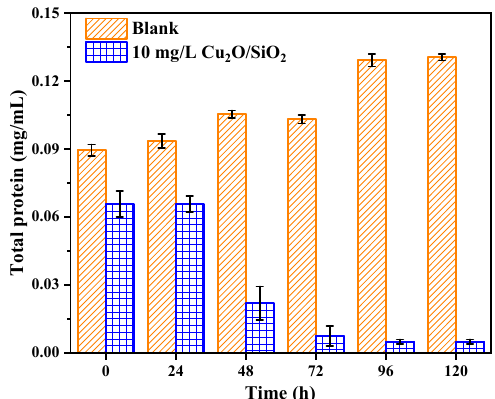
Figure 9. Changes in total protein content of algae during the experiment.